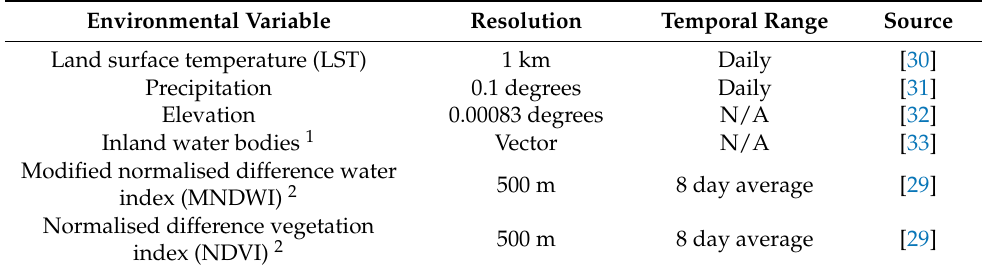
Table 1. List of environmental data used in the